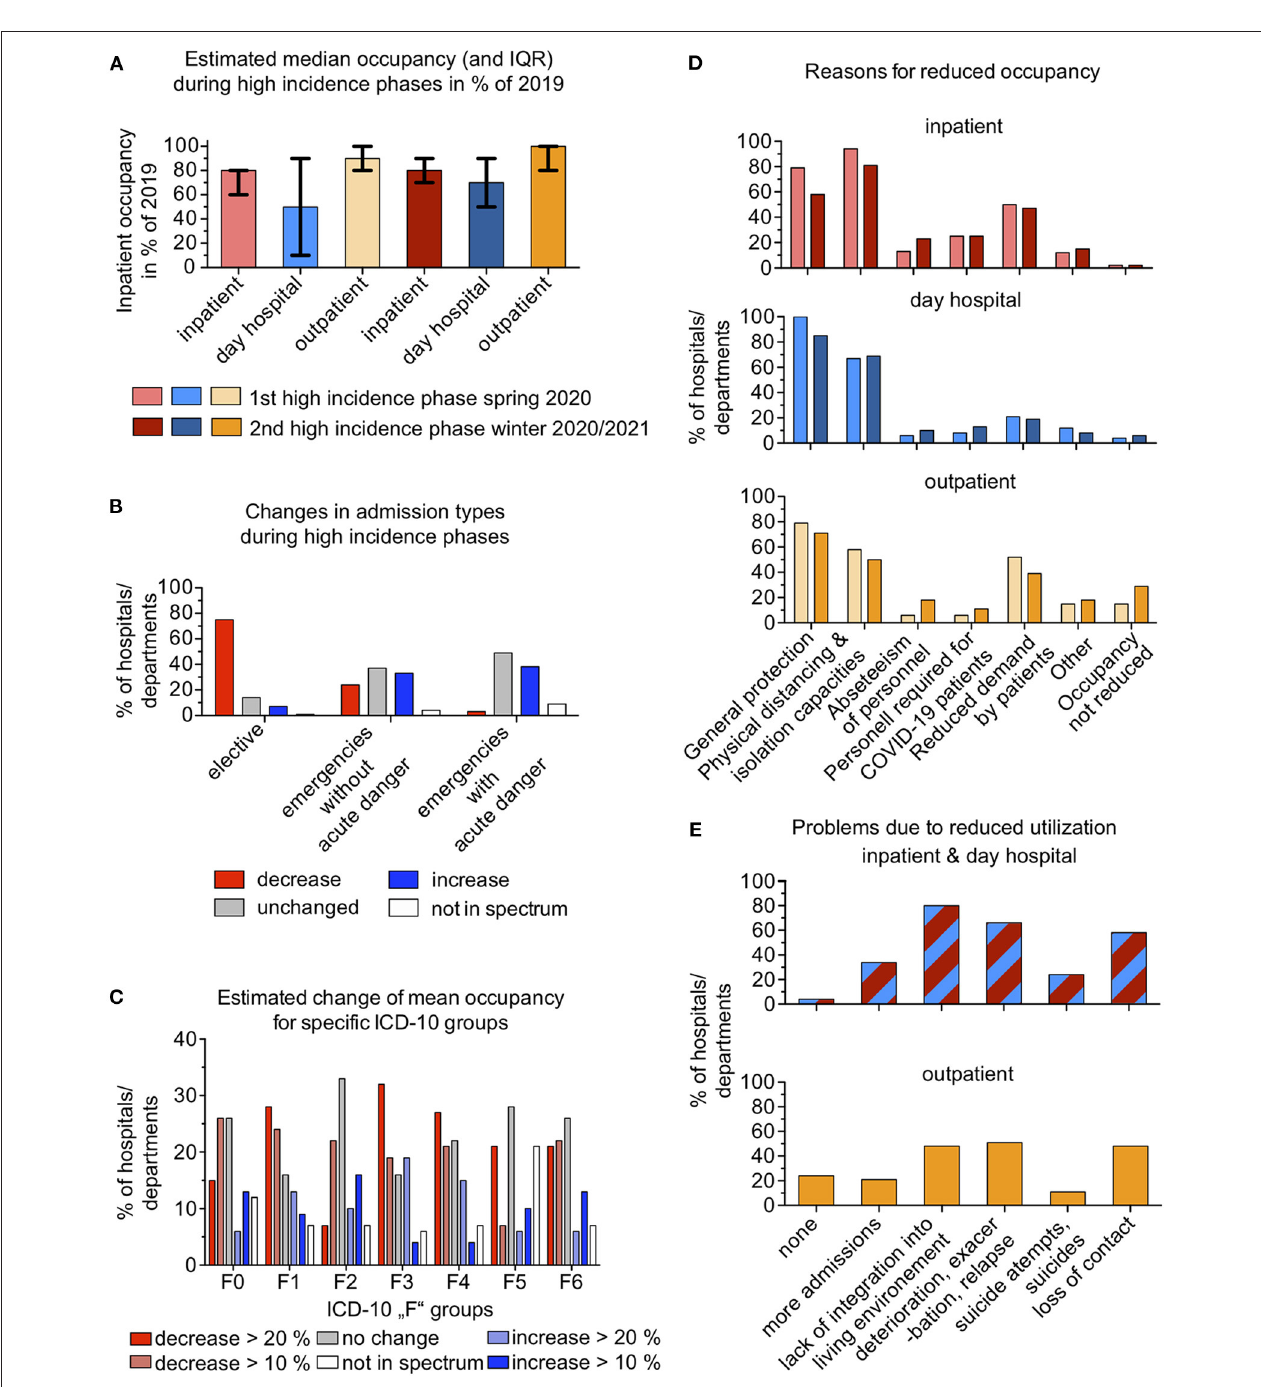
FIGURE 1 | (A) shows medians and interquartile ranges of the estimated occupancy during the high incidence phases of the COVID-19 pandemic in Germany in spring 2020 and winter 2020/2021 as a percentage of the occupancy during the equivalent periods in 2019. Red, inpatient occupancy; blue, day hospital occupancy; yellow, occupancy in hospital outpatient clinics. (B) shows changes in admission types during both high incidence phases (spring 2020 and winter 2020/2021) compared with the equivalent periods in 2019. Red, percentage of departments that reported a decrease in the mentioned admission type; gray, percentage of departments that reported no change in the mentioned admission type; blue, percentage of departments that reported an increase in the mentioned admission type. (C) shows the estimated change of mean occupancy for specific ICD-10 groups in both high incidence phases. F0, organic mental disorders; F1, addiction disorders; F2, psychoses; F3, affective disorders; F4, neurotic, stress-related, and somatoform disorders; F5, eating disorders; F6, personality disorders. (D) shows selected reasons for a reduced occupancy during the two high incidence phases of the pandemic. For other reasons, refer to Supplementary Table S2 . Red, inpatient care; blue, day hospital care; yellow, hospital-based outpatient care. Lighter colors, first high incidence phase in spring 2020; darker colors, second high incidence phase in winter 2020/2021. (E) shows selected problems due to a reduced utilization of services during the two high incidence phases. For other reasons, refer to Supplementary Table S2 . Red/blue, inpatient and day hospital care; yellow, hospital-based outpatient care.